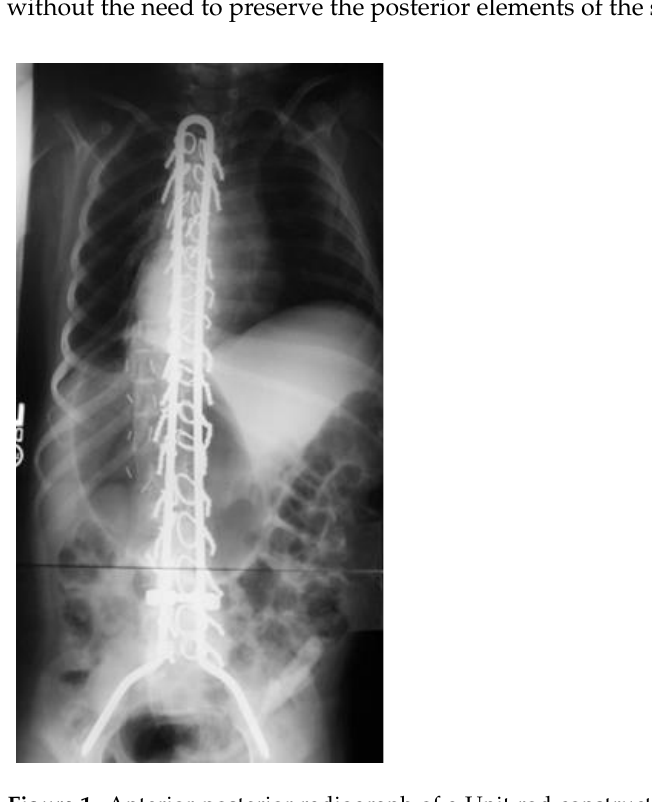
Figure 1. Anterior-posterior radiograph of a Unit rod construct using Luque wiring used for the treatment of a patient with neuromuscular scoliosis.